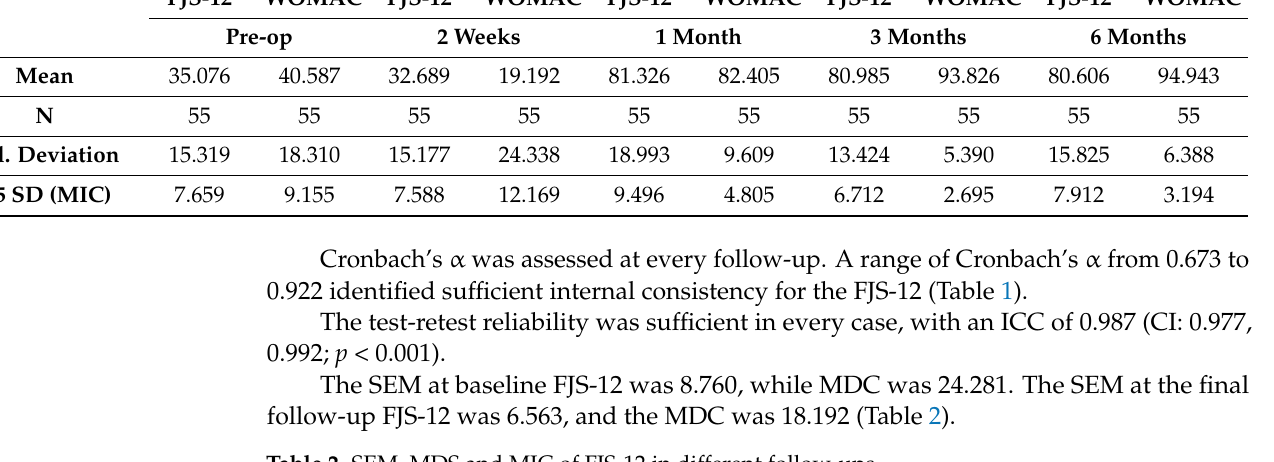
Table 2. SEM, MDS and MIC of FJS-12 in different follow-ups.